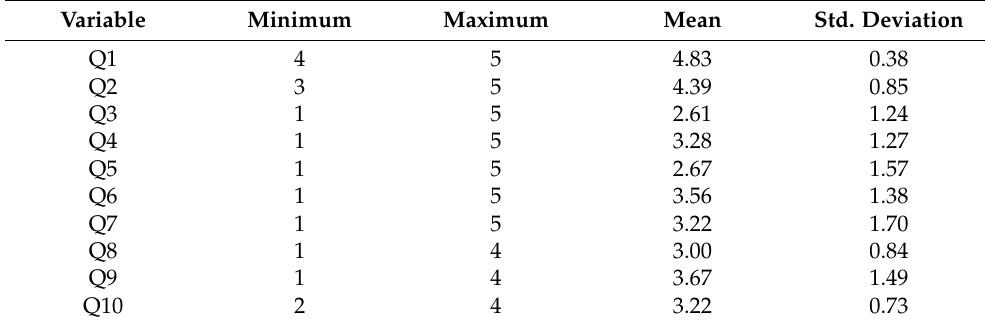
Table 13. Survey conducted with students on the project, BIM, and university-company collaboration: Statistical Results. Variable Minimum Maximum Mean Std. Deviation Q1